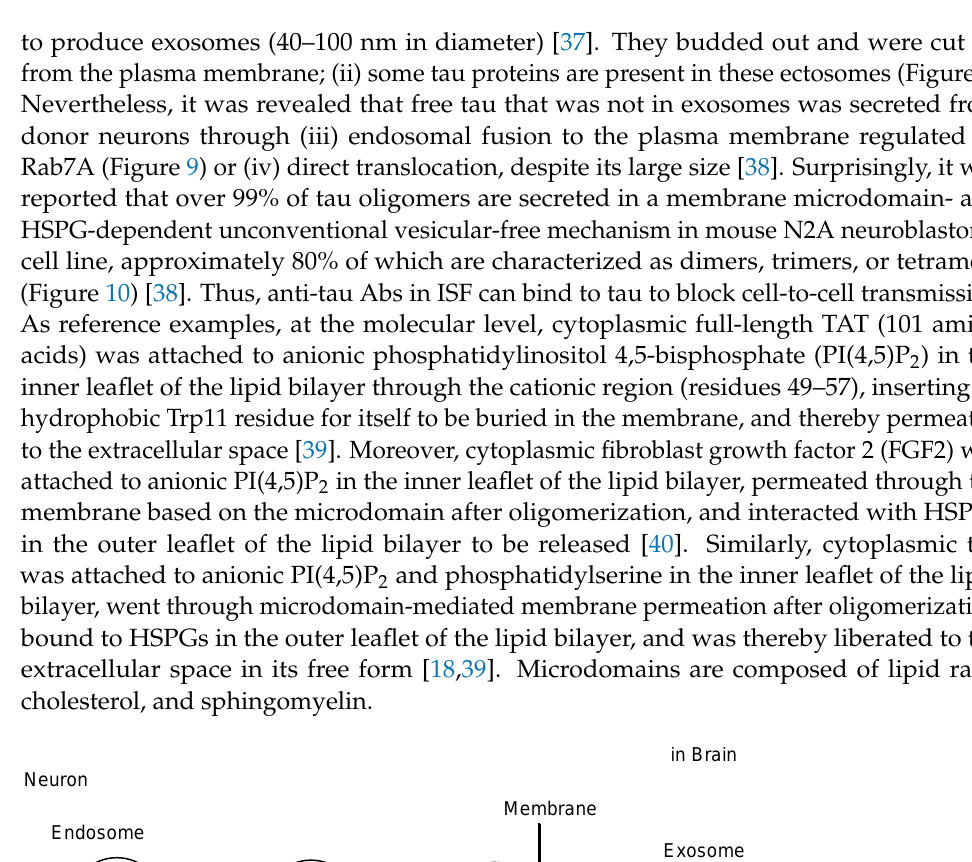
Figure 9. Tau secreted from neurons based on the endolysosomal machinery.